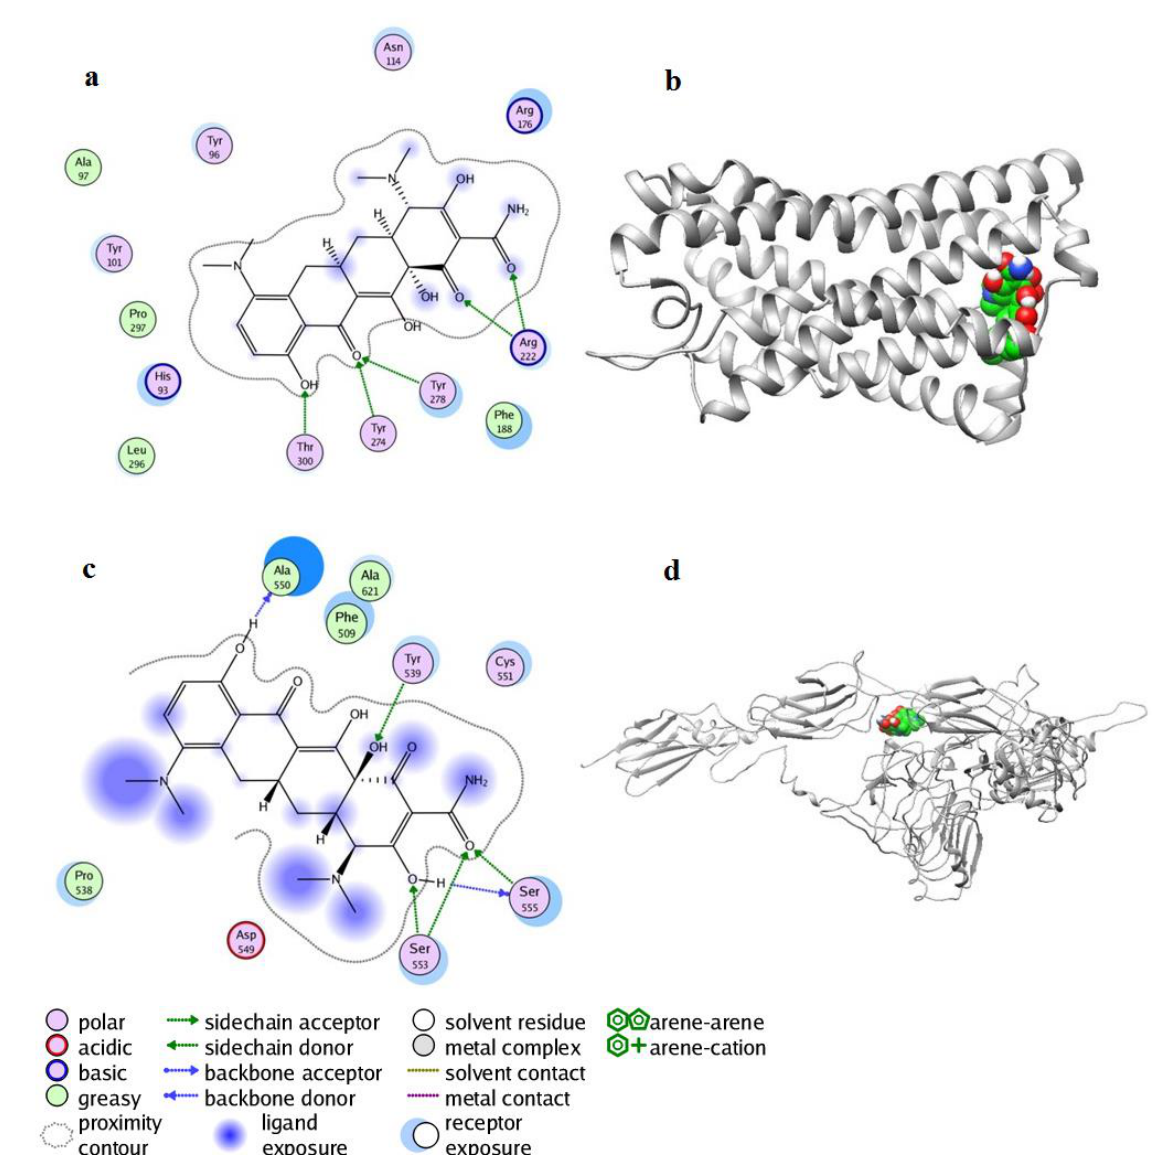
Figure 1: Molecular docking results: ( a ) two-dimensional display of interaction between CMKLR1 and minocycline. ( b ) Three-dimensional interaction between CMKLR1 and minocycline. ( c ) Two- dimensional display of the interaction between INSR and minocycline. ( d ) 3D displays of the interac- tion between INSR and